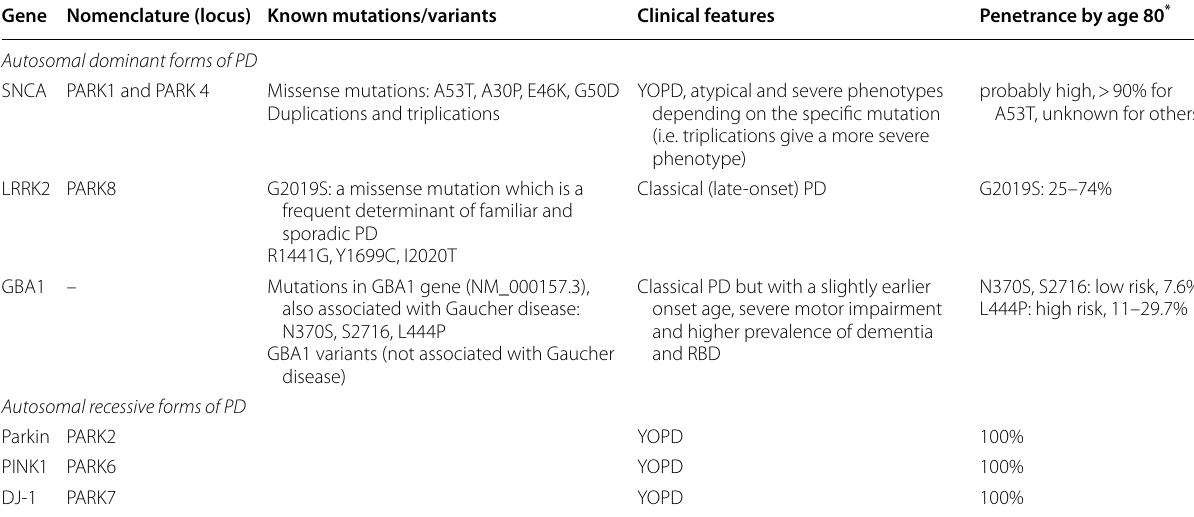
PD Parkinson’s disease, SNCA α-synuclein, LRRK2 leucine-rich repeat kinase 2, GBA glucocerebrosidase, RBD REM sleep behavior disorder, YOPD young onset PD, PINK1 PTEN induced putative kinase 1 *As determined by Heinzel et al. (2019)